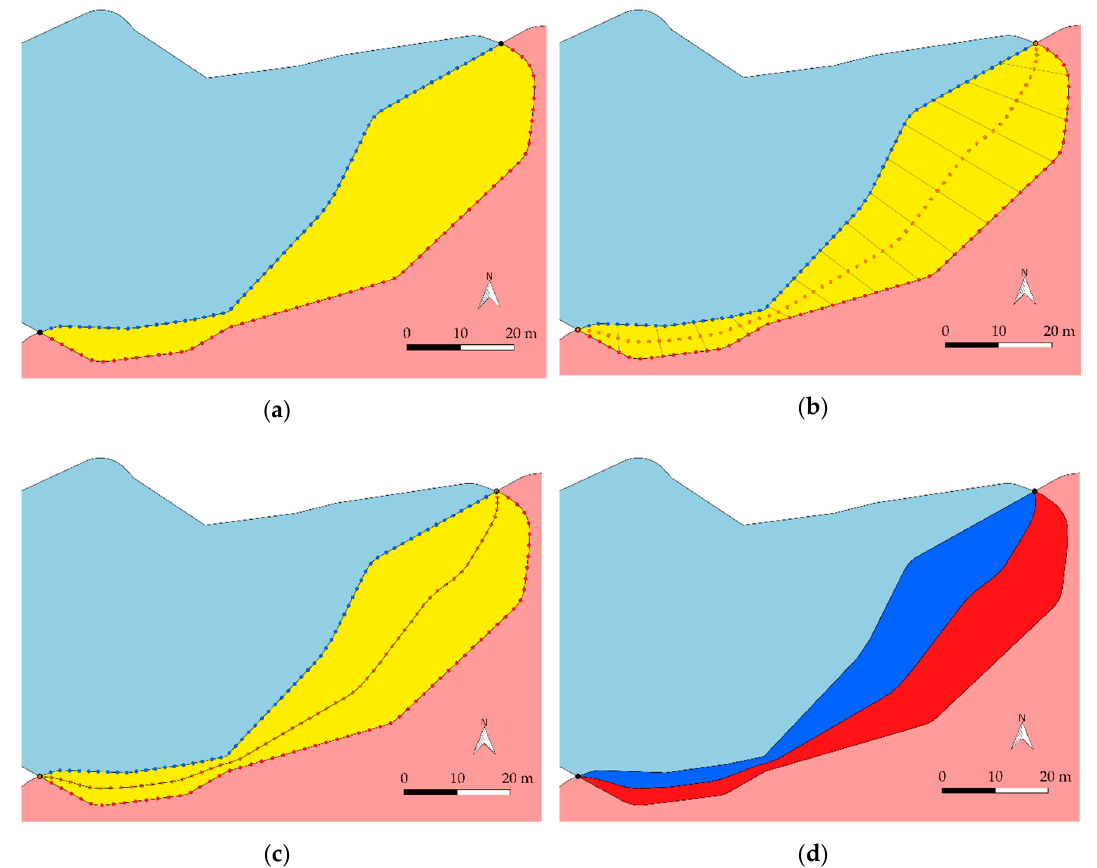
Figure A4. Detailed stages of Algorithm A3. Original polygons are shown with blue and red colors, and their intersection zone with yellow color. The ETRS-TM35FIN (EPSG:3067) coordinate system is used in the figure. ( a ) The two black dots mark the intersections of the polygon boundary lines (vertex points). Smaller blue and red dots mark the points generated to the side lines of the intersection polygon. ( b ) The division points (orange) are averaged from the point pairs at the boundaries of the intersection polygon. Few grey lines show examples of the averaging. ( c ) The division line is created from the ordered points. ( d ) The intersection polygon is split with the division line and the halves are addressed to the original polygons (from which the intersection polygon was erased). The updated stand boundary is formed between the stands.